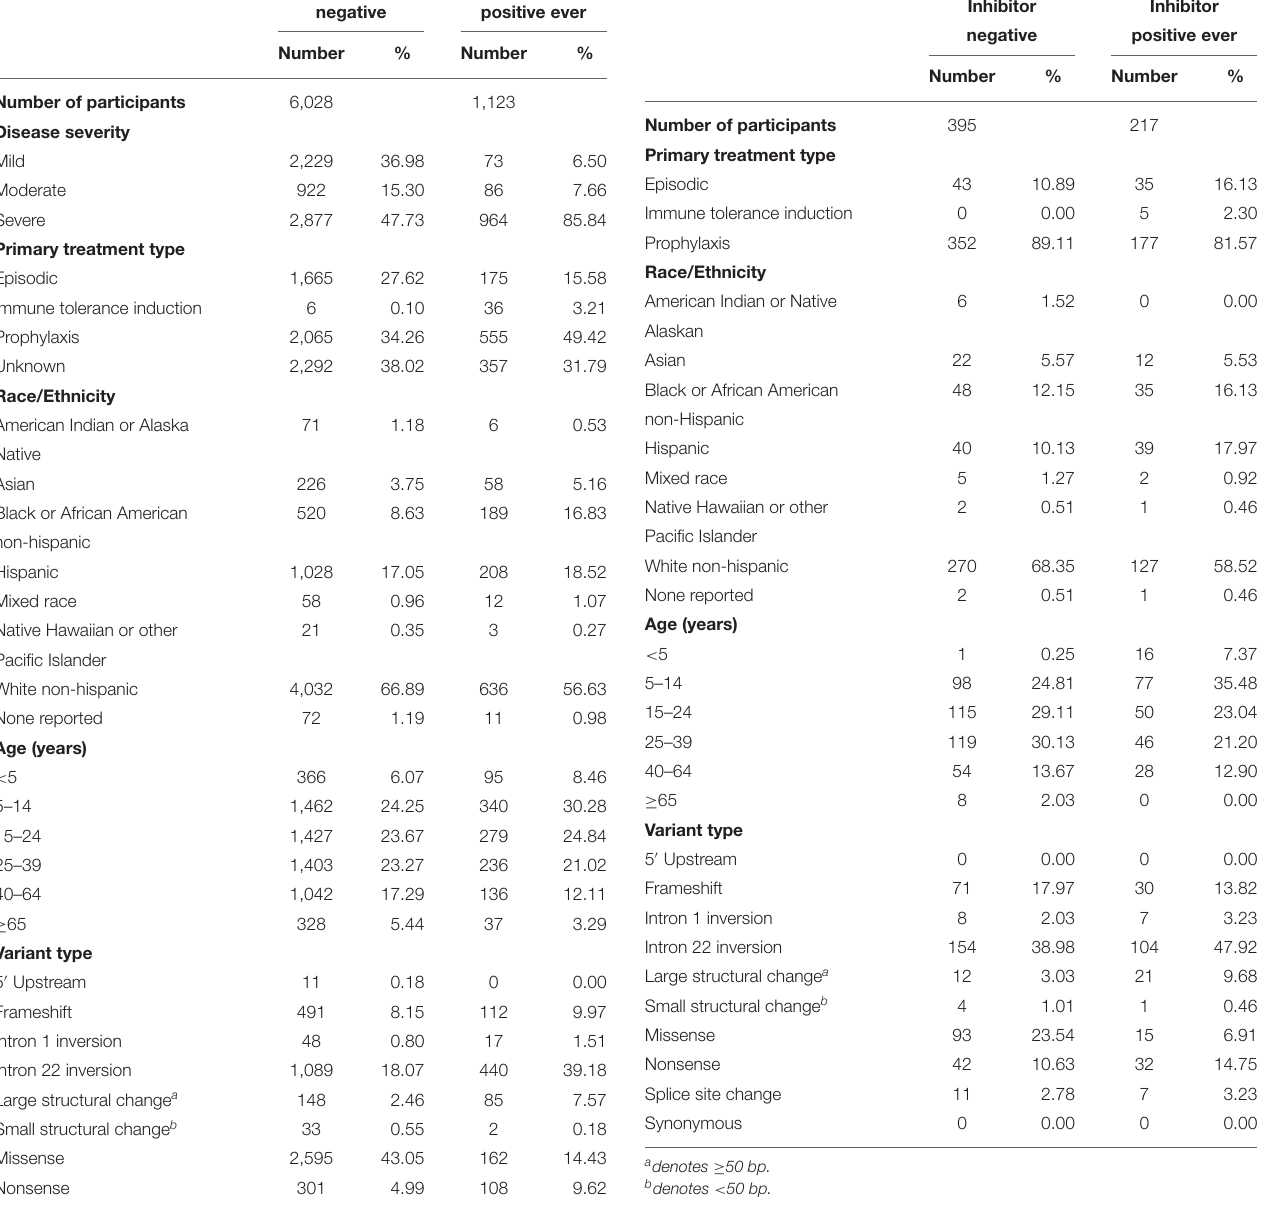
TABLE 1 | Participant characteristics, the ATHNdataset. TABLE 2 | Participant characteristics, HLA typed participants with severe